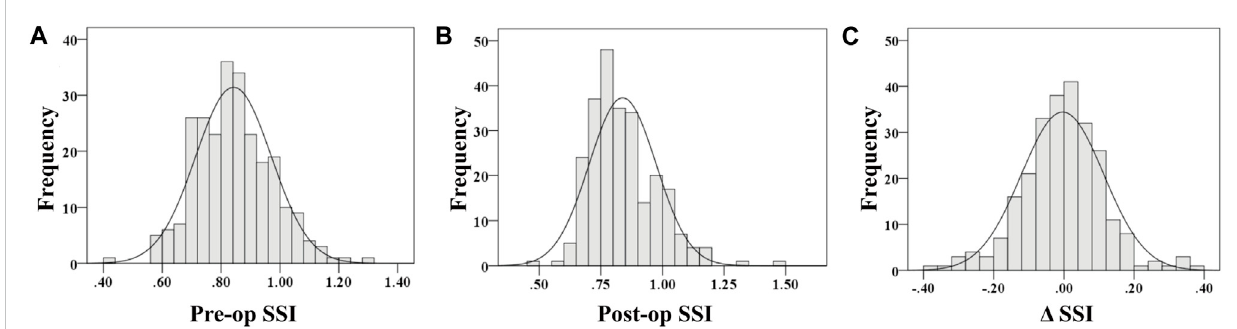
FIGURE 1 Distribution of pre-op stress-strain index (A) , post-op stress-strain index (B) and Δ stress-strain index (C) .